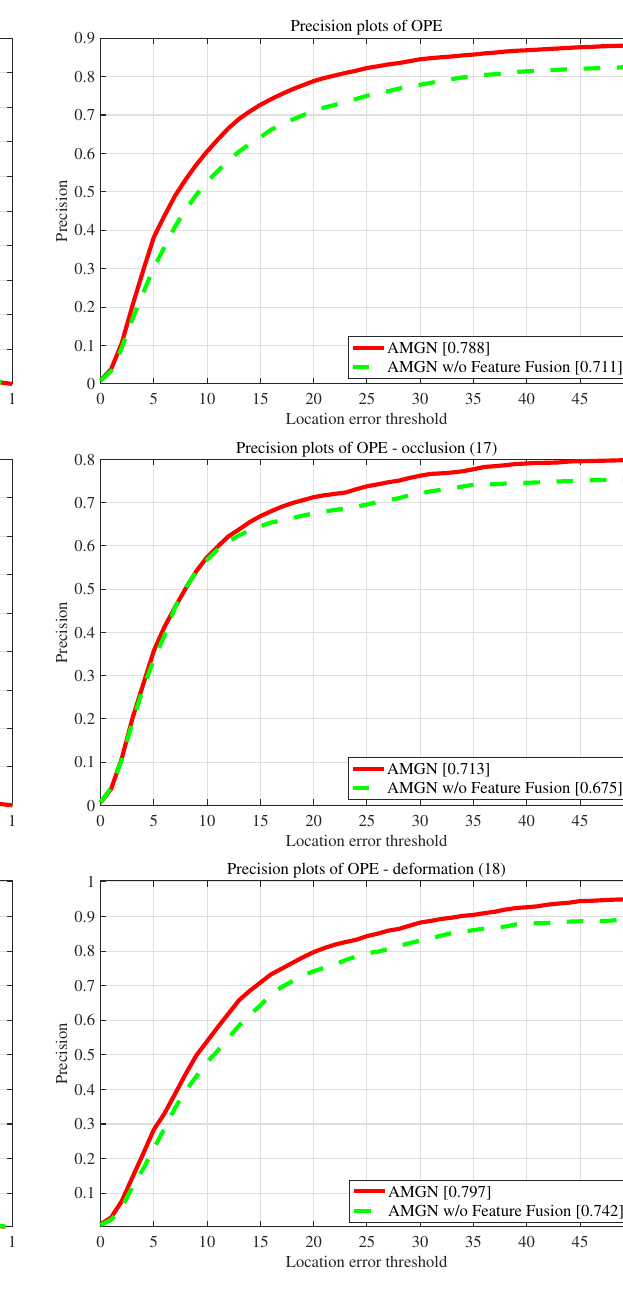
Figure 12. Ablation studies results on feature fusion on the DTB70